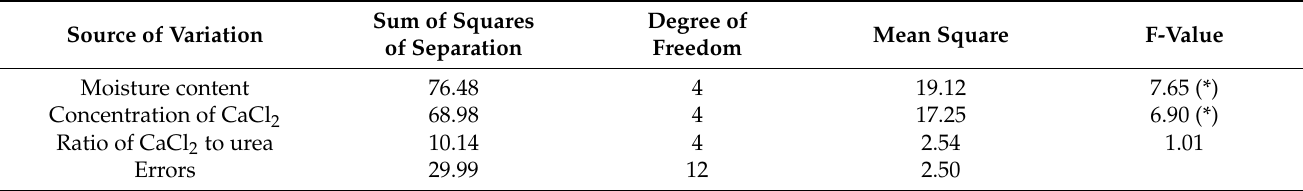
Table 5. The orthogonal experiment result analysis. * Significance of